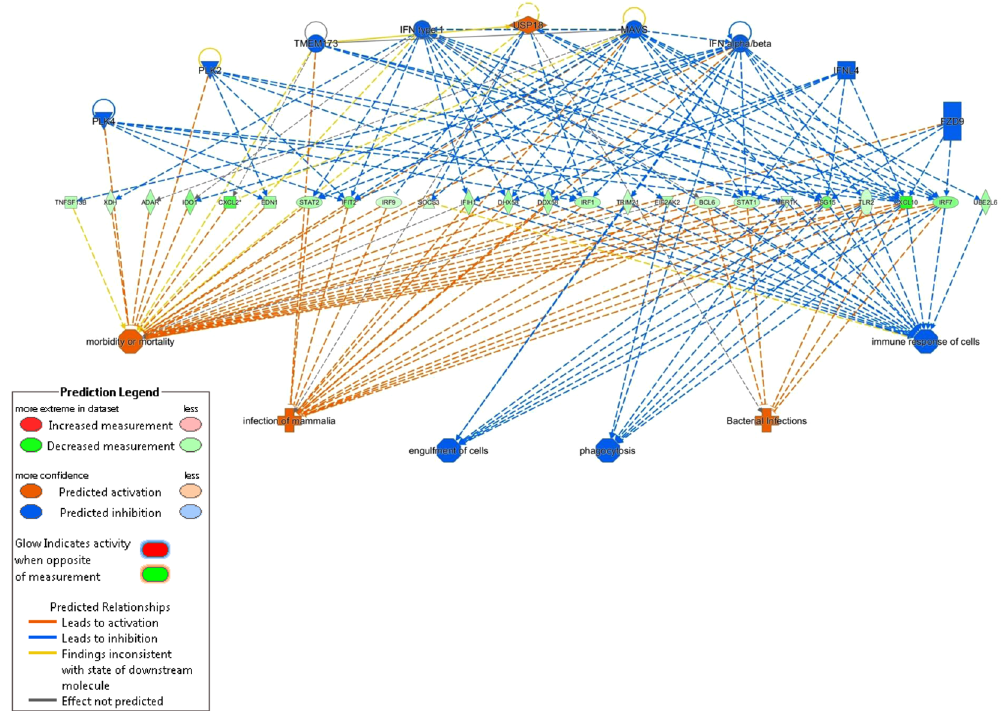
Figure 4. Regulator effects in comparison of Beef CL 48 h and Beef LF 48 h. Bacterial Infections, engulfment of cells, immune response of cells, infection of Mammalia, morbidity or mortality, phagocytosis regulator effects network. Image highlights predicted activation (orange lines) of bacterial interactions, morbidity/mortality, and infection of Mammalia in the Beef CL 48 h compared to Beef LF 48 h, with predicted inhibition of engulfment of cells and phagocytosis, and immune response predicted to be inhibited (blue lines) at the 48 timepoints in beef CL v beef